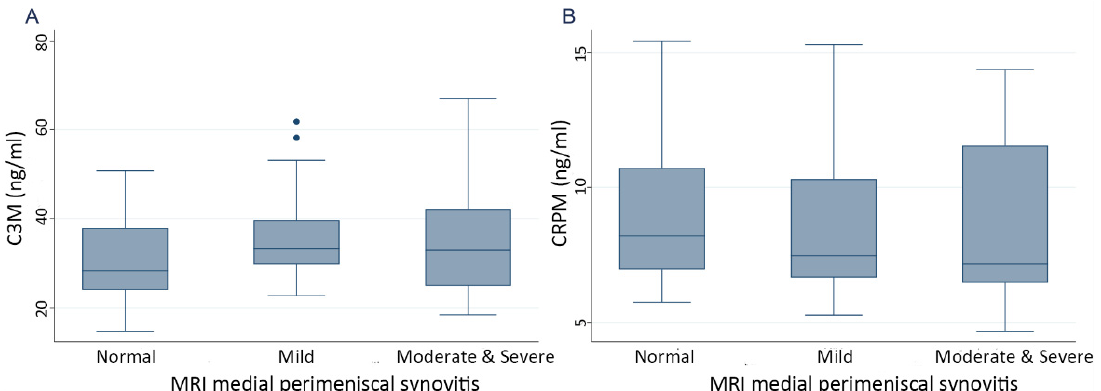
Figure A1. Biochemical marker level by grade of medial perimeniscal synovitis. ( A ) Type III collagen degradation (C3M); ( B ) metabolite of C-reactive protein (CRPM).